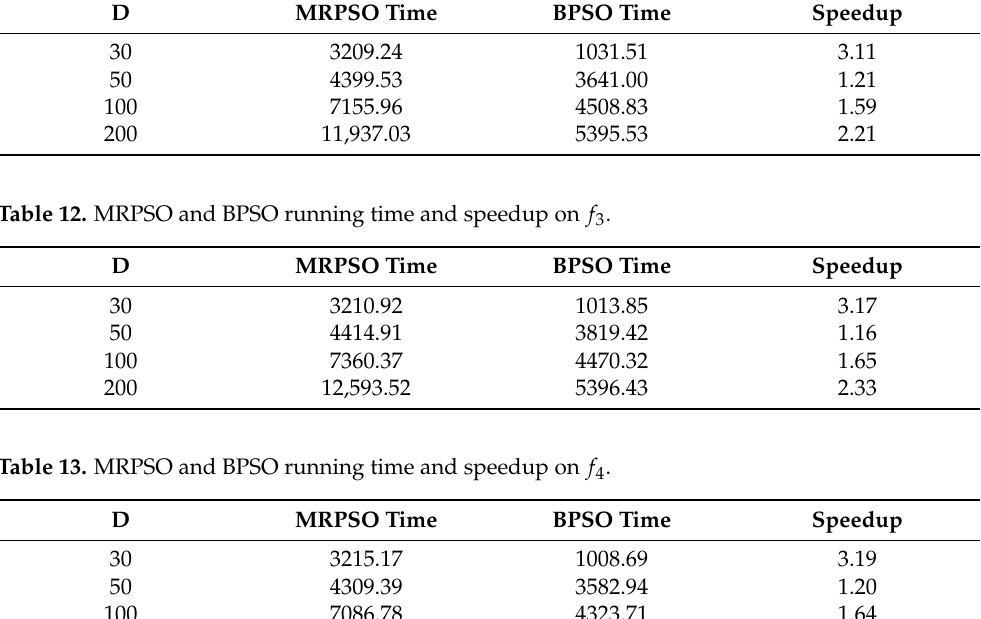
Table 11. MRPSO and BPSO running time and speedup on f 2 .